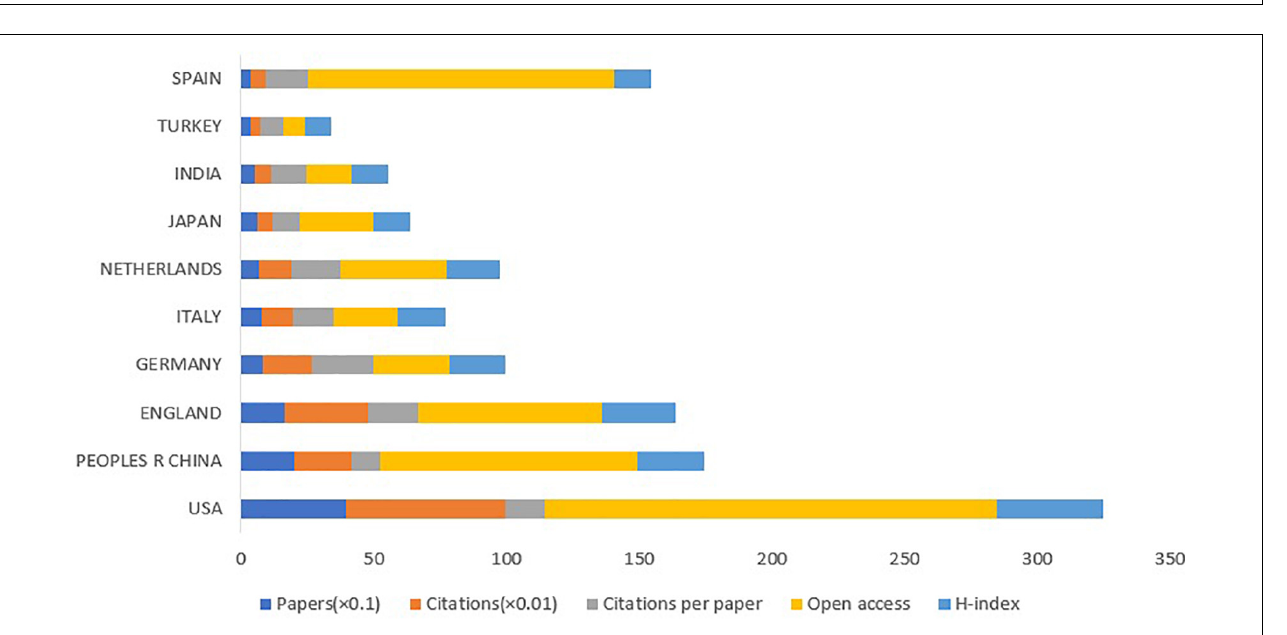
FIGURE 4 | The dual-diagram overlay of journals related to DPNP research.